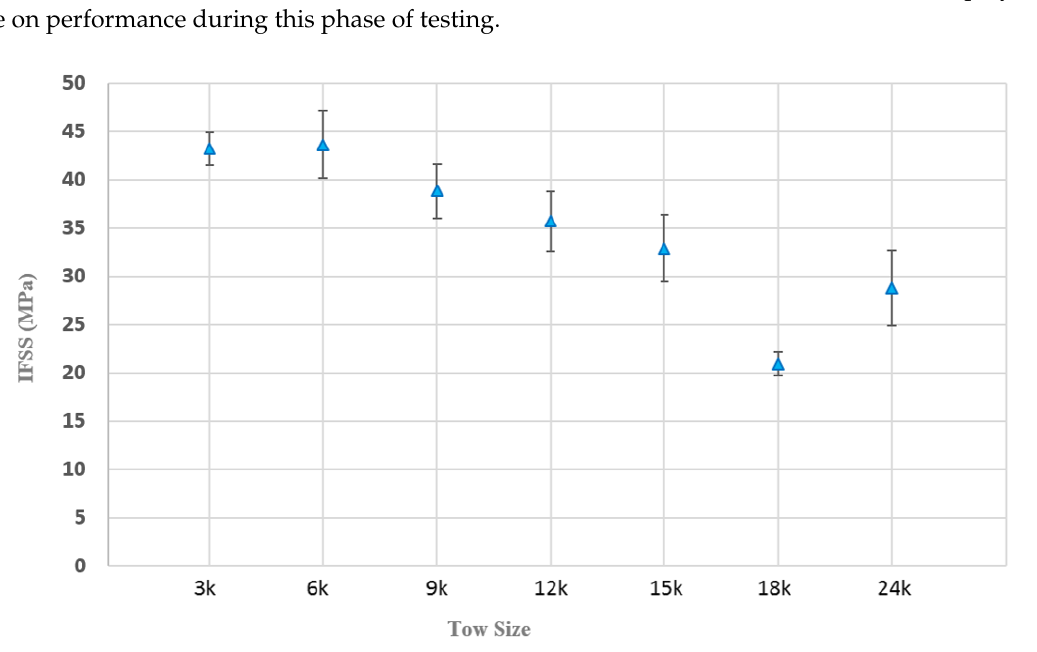
Figure 5. IFSS results of 3 k, 6 k, 9 k, 12 k, 15 k, 18 k and 24 k T300 fibers.